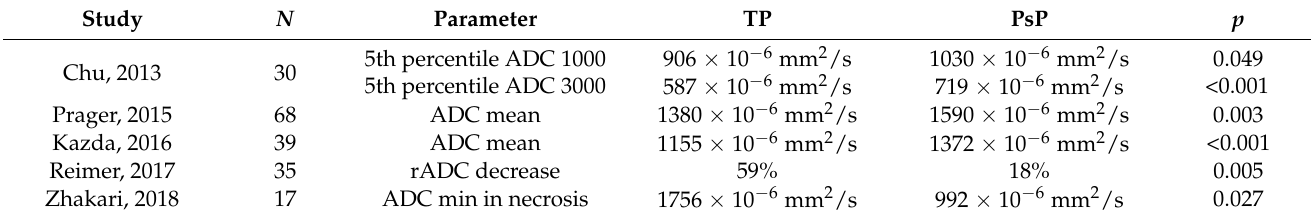
Table 1. Review of DWI MRI studies. DWI = diffusion-weighted imaging, MRI = magnetic resonance imaging, N = number of patients, TP = true progression, PsP = pseudoprogression, ADC = apparent diffusion coefficient, rADC = relative apparent diffusion